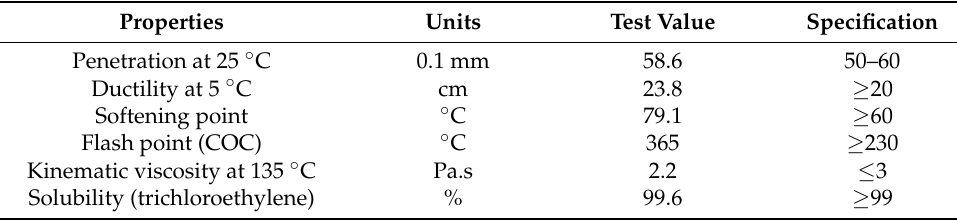
Table 1. Basic performance indicators of SK Speedway modified asphalt.